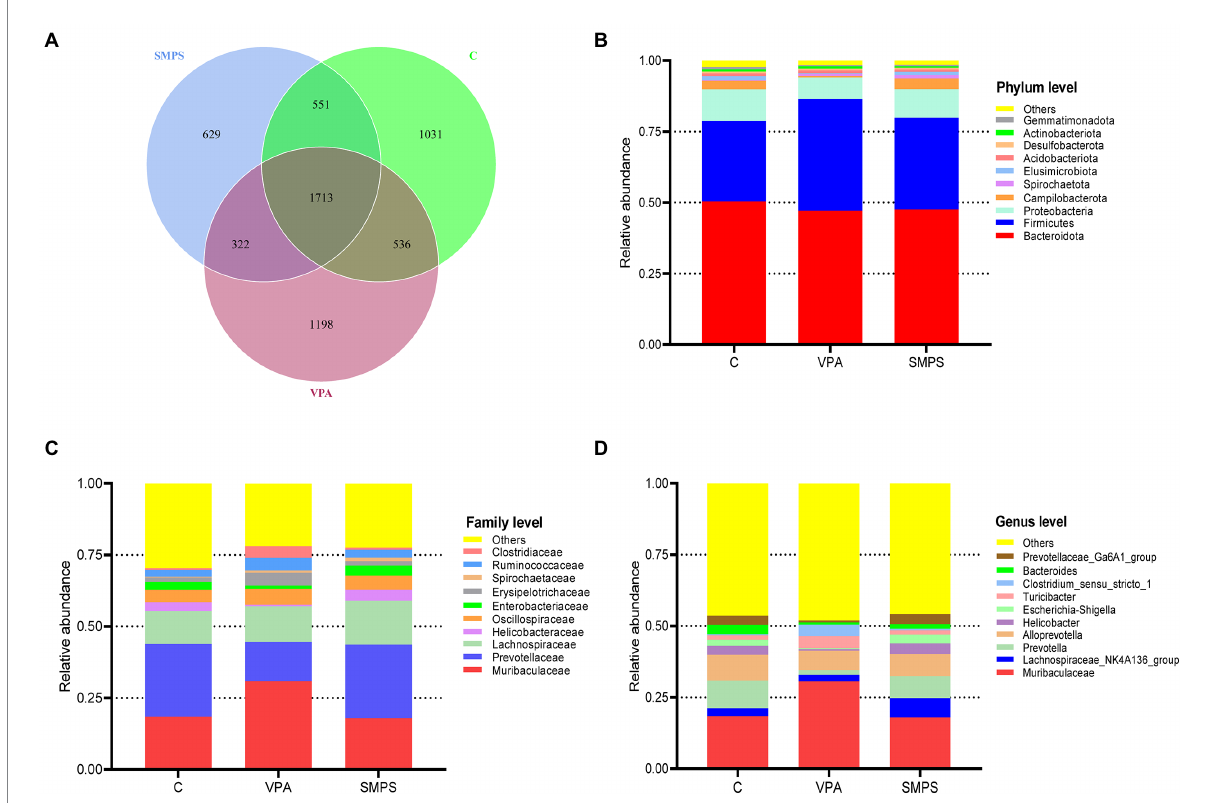
FIGURE 2 Characteristics of the gut microbiota among the SMPS, VPA and C groups ( n = 8 per group). (A) Venn diagram for these groups. The number of mutual ASVs in the groups. Top 10 species at the (B) phylum level, (C) family level, and (D) genus level. (SMPS, SMPS intervention group; VPA, VPA induced autism model group; C, control